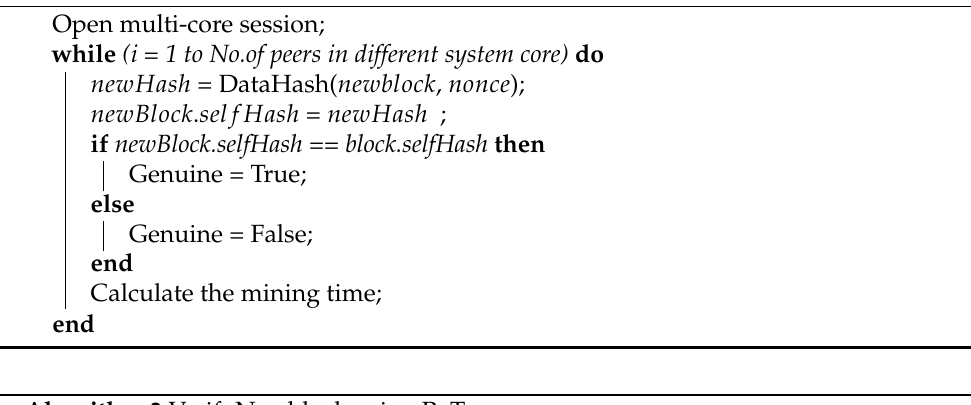
Algorithm 2 VerifyNewblock using PoW